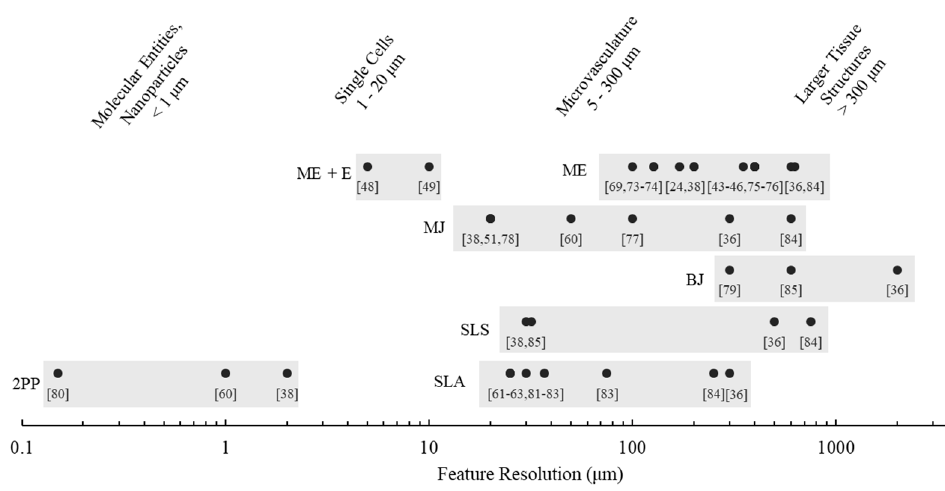
Figure 2. Maximum feature resolution of various 3D printing techniques, as compared to typical biological entities. Most techniques can print in the range of microvasculature; expensive, specialized methods, such as two-photon polymerization (2PP) and electrospinning hybrid extrusion (ME + E) are required for printing sizes comparable to single cells. Material extrusion (ME) feature resolution is essentially limited by nozzle size, while material jetting (MJ) and binder jetting (BJ) feature resolution is limited to droplet size. Binder jetting and selective laser sintering (SLS) feature resolution both depend on particle powder size, while stereolithography (SLA) has superior feature resolution based on the light source. However, for all print types, feature resolution depends highly on the designed geometry and print orientation. Data was compiled from manufacturer technical specification sheets [43–46,48,49,51,61–63,69,73–83] and literature [24,36,38,60,84,85]. Material extrusion values extracted from specification sheets are based on nozzle diameter. Table 1. Representative commercial printers with their associated feature resolutions and applications in the literature. Feature resolution data is taken from manufacturer technical specification sheets. Material extrusion values extracted from specification sheets are based on nozzle diameter. However, the smallest feature size is dependent on geometry, print speed, temperature, and material, and is not standardly reported. High-resolution printing techniques find applications in the printing of oral dosages, microneedles, micro-swimmers, and micro-implants. Material extrusion is a popular technique in the printing of oral dosages, whereas the feature resolution of stereolithography and two-photon polymerization are necessary for use in microneedles and